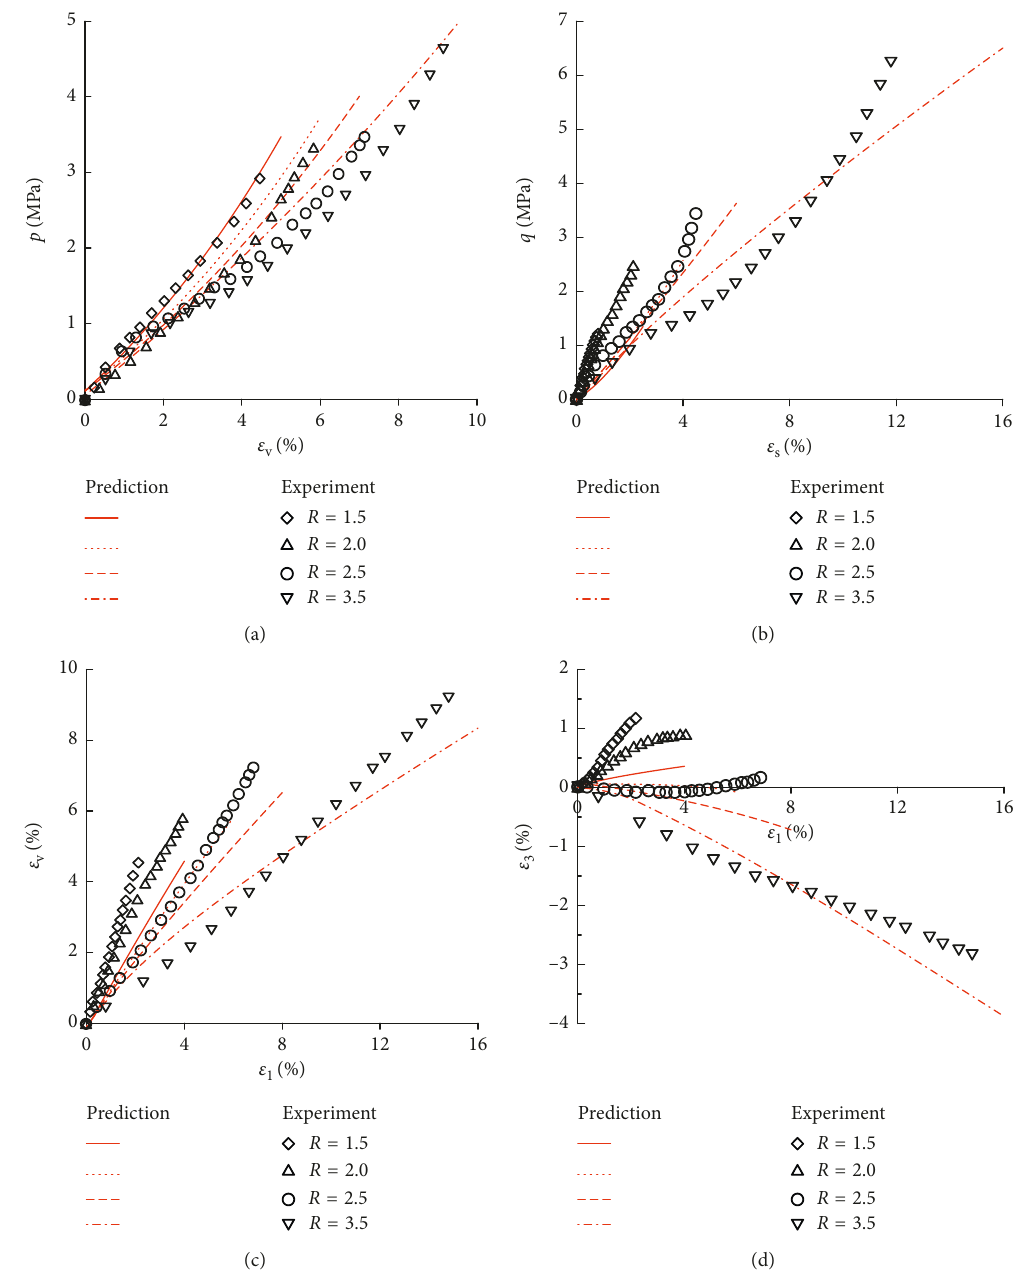
Figure 11: Predicted results of modified generalized plasticity model for CR test. (a) Spherical stress-volume strain curve. (b) Deviatoric stress-deviatoric strain curve. (c) Volumetric strain-axial strain curve. (d) Radial strain-axial strain